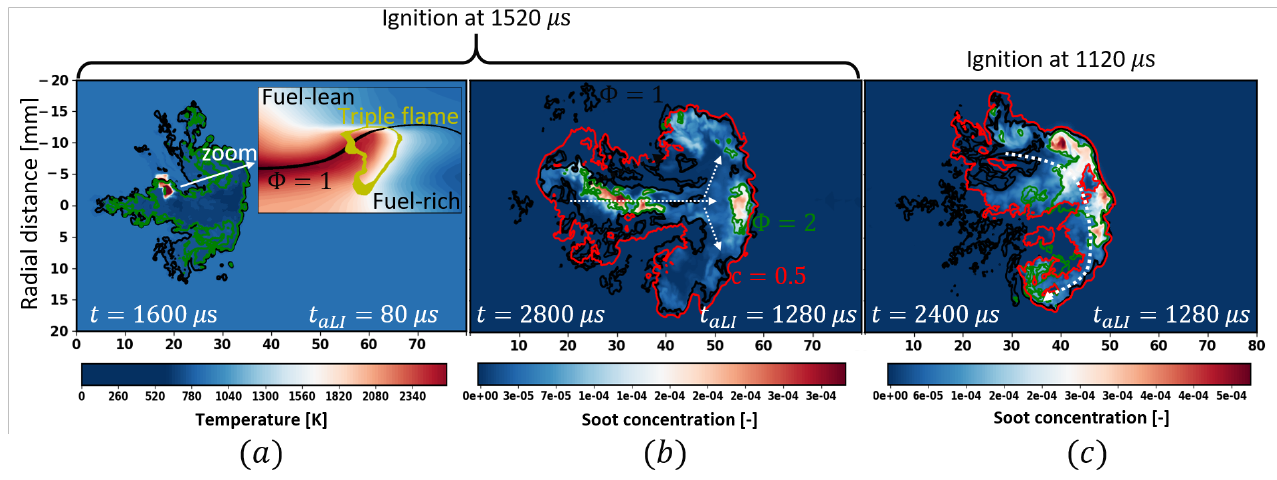
Figure 12. Slices of temperature ( a ) and soot concentration (( b , c ) images) for ignition at 1.12 ( c ) and 1.52 ms ( a , b )). The black line shows the stoichiometric mixture ( Φ = 1). The green line indicates Φ = 2. The flame boundary is illustrated by the progress variable ( c = 0.5). The yellow line, used to show the triple flame, corresponds to a heat release of 4 × 10 11 W/m 3 . The dashed arrows illustrate the flame